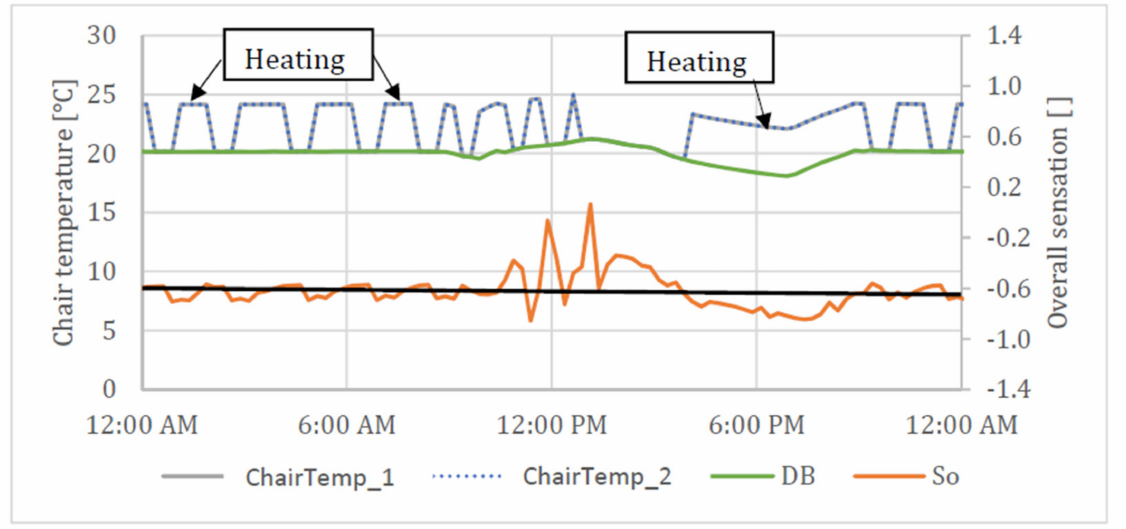
Figure 13. One-day simulation with office chair and heating function in January for Mannheim (Germany).